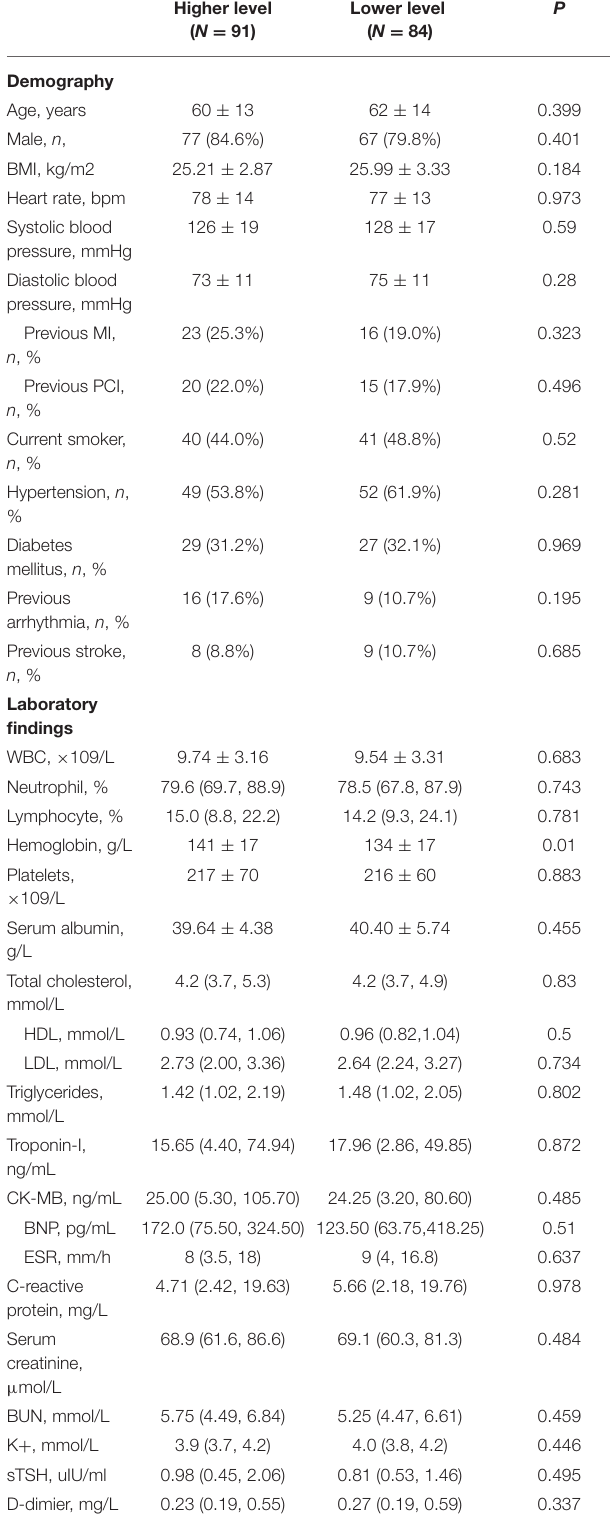
TABLE 1 | Basic clinical, laboratory and treatment in AMI patients with higher and lower TSLP levels in